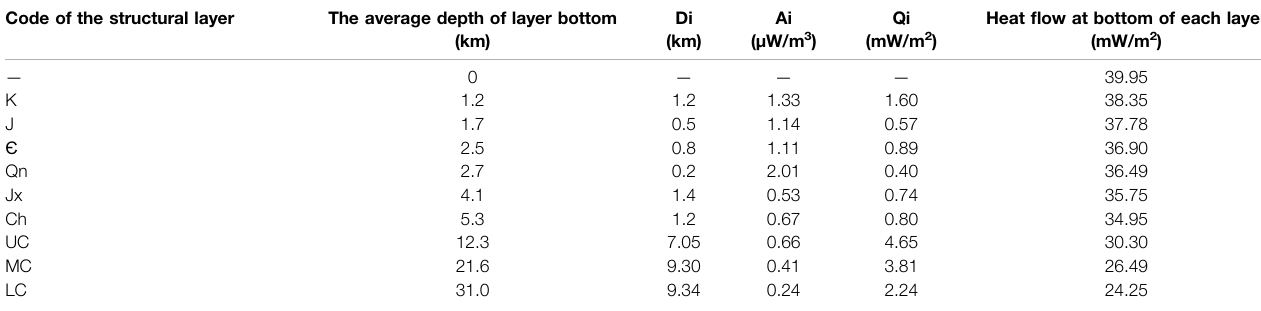
TABLE 3 | Calculation result of lithospheric thermal structure in the Yanheying Basin. Code of the structural